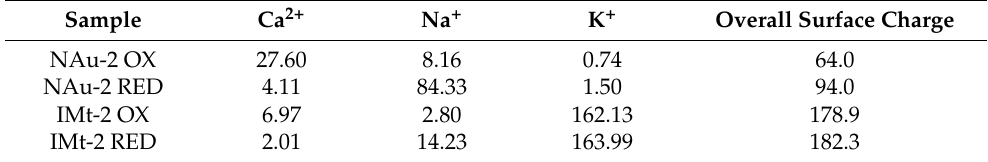
Table 4. Exchangeable cation (Ca 2+ , Na + , K + ) amounts and exchangeable cationic charge of oxidised and reduced NAu-2 and IMt-2 measured with ICP-OES, expressed as mmol/100 g. Overall surface charge was calculated based on Ca 2+ , Na + and K + amounts and charge; given in